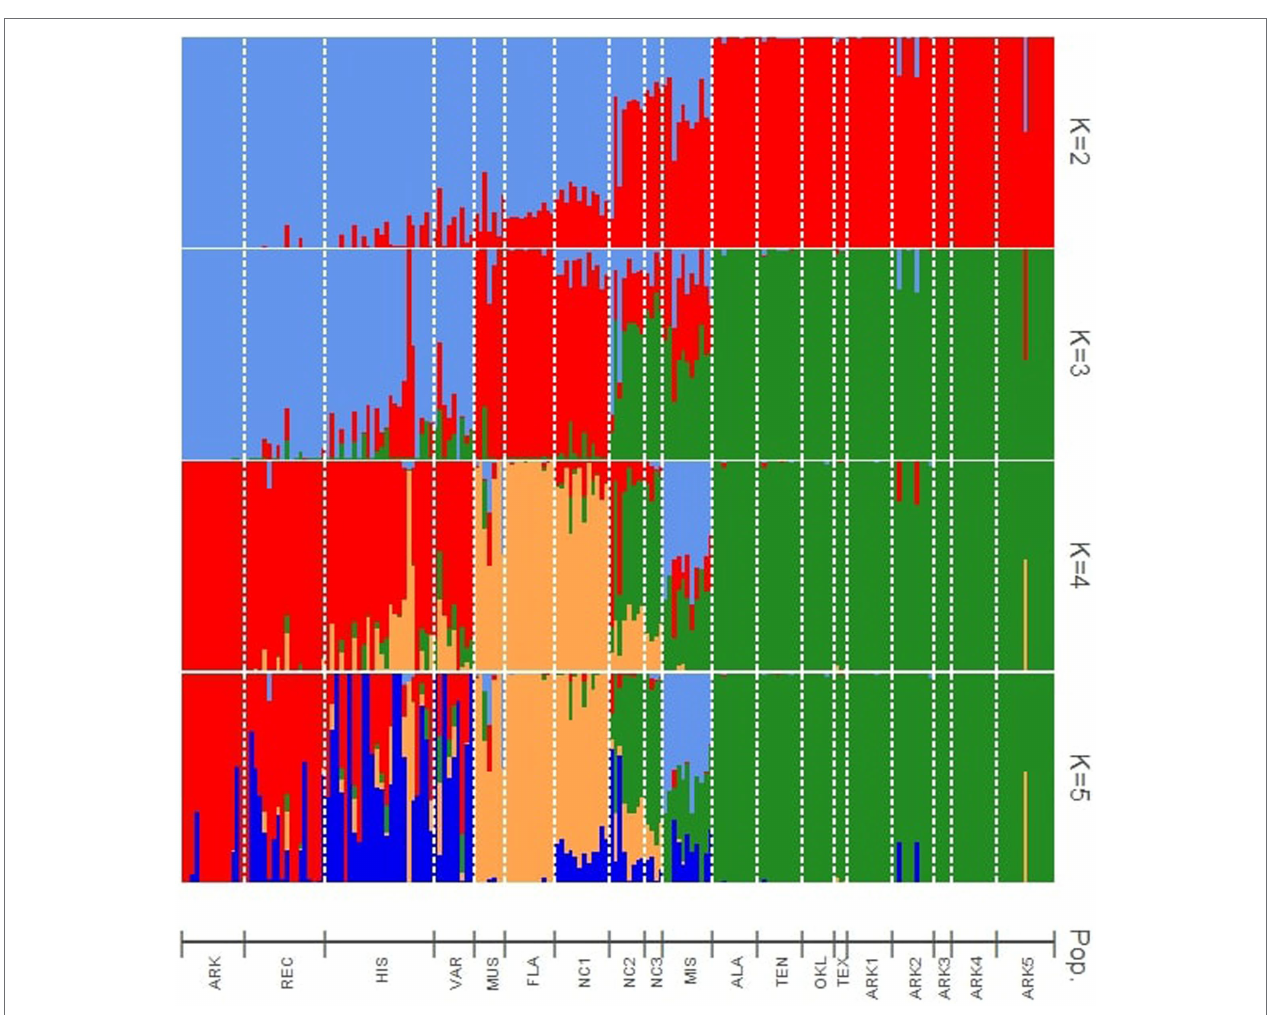
FIGURE 1 | Bayesian structure analysis results showing assignments to four theoretical levels of K (2–5). Vertical bars indicate the estimated membership coefficients (Q) of each individual for each population